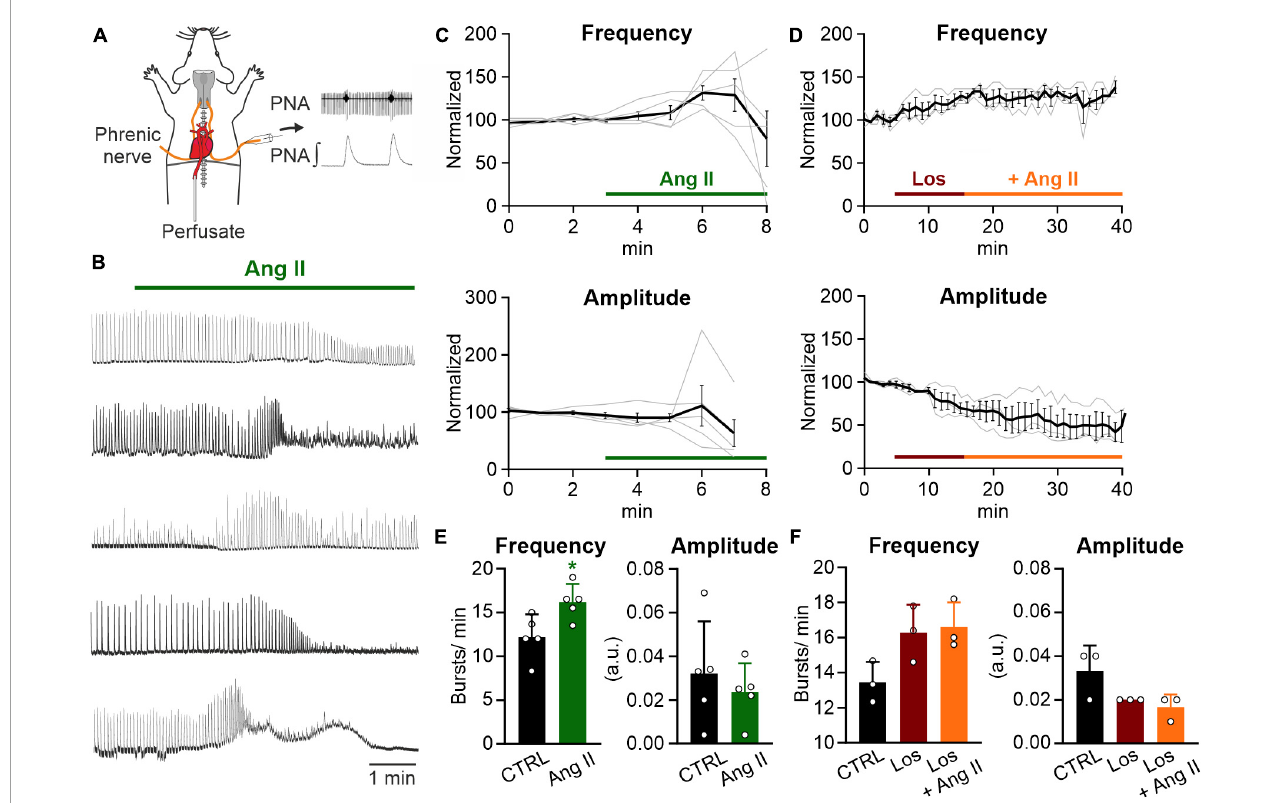
FIGURE1 Ang II increases respiratory rate in the WHBP. (A) Illustration of the working heart-brainstem preparation (WHBP) showing recordings of phrenic nerve activity (PNA). (B) Recordings of the integrated PNA in response to Angiotensin II (Ang II) treatment. (C,D) Graphs show the frequency and amplitude of PNA over time. Signals after treatment were normalized to the baseline (control condition). Gray traces show each individual recording and the black trace the mean value. (C) Treatment with Ang II alone (100–500 nM; N = 5 mice, 3 male and 2 female) and (D) a 12 min pre-treatment with losartan (Los; 5 µ M) followed by the co-application of Ang II (500 nM; N = 3 female mice). (E) Charts show the averaged data of 2 min time intervals for the different conditions for frequency and amplitude (CTRL 1–3 min, Ang II 6–8 min). (F) Charts show the averaged data of a 3 min time interval for CTRL and a 5 min